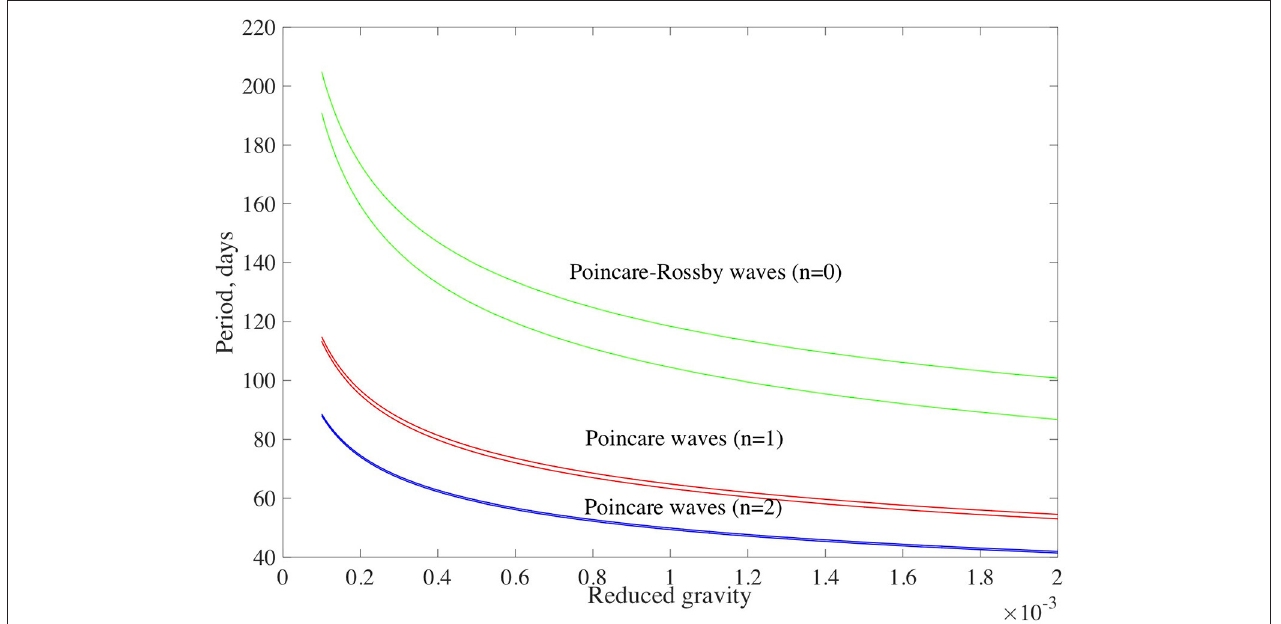
FIGURE 7 | Period of equatorial Poincare waves vs. the value of normalized reduced gravity, G . Red and blue lines correspond to n harmonics, respectively. Green lines correspond to n